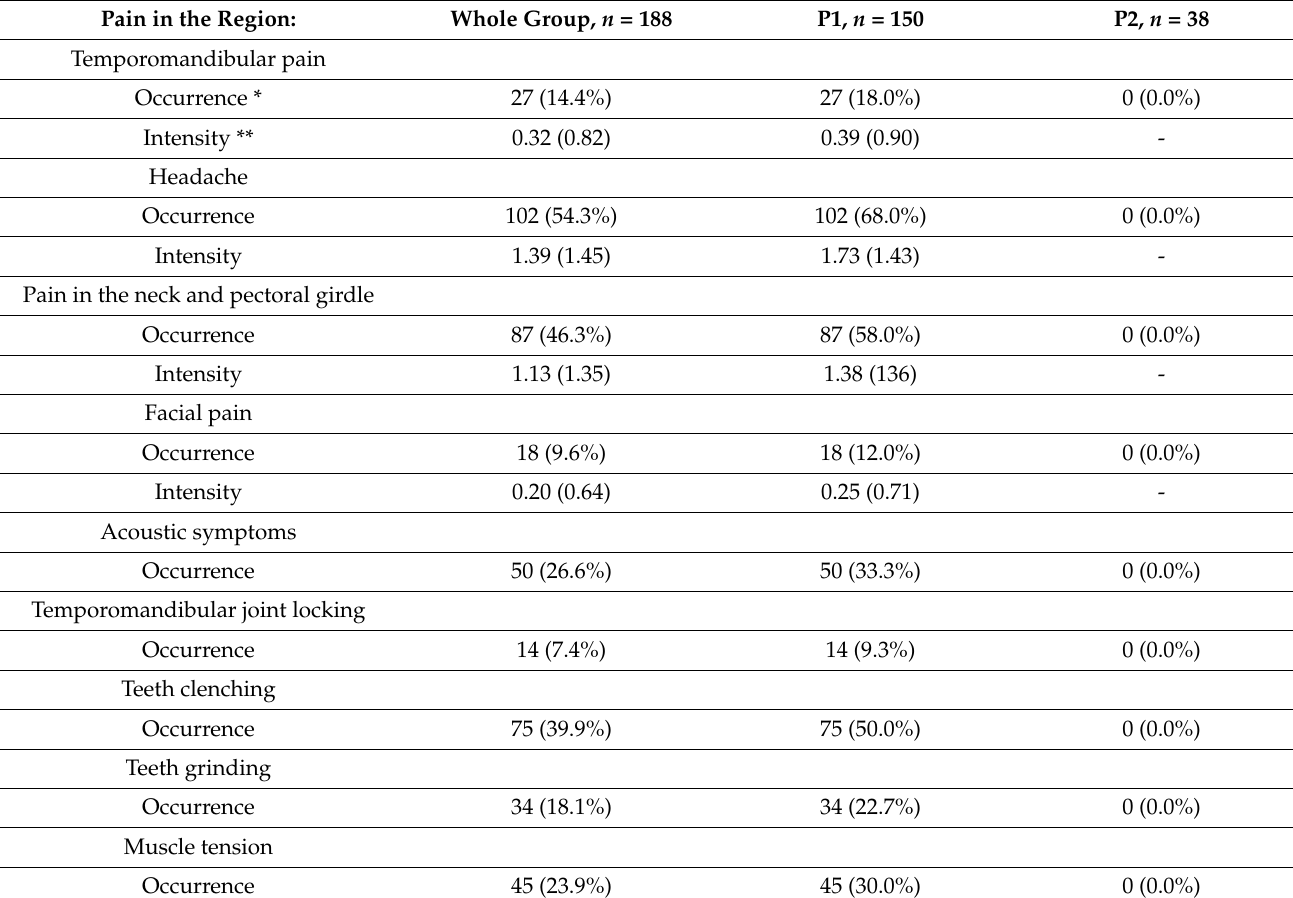
Table 1. Characteristics of the study group in terms of experienced SS